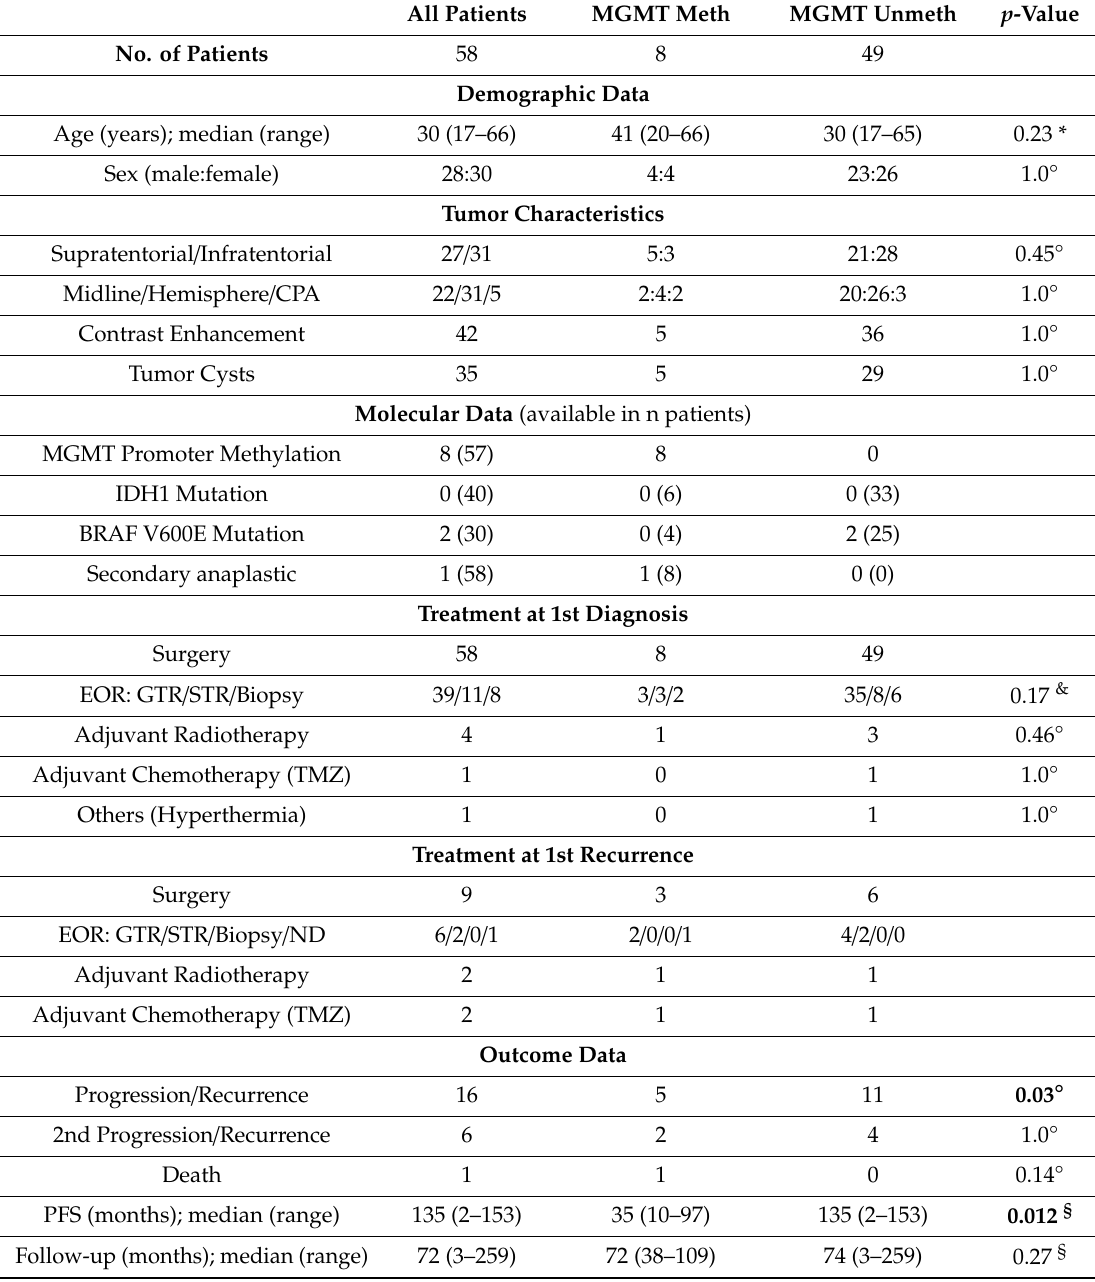
Table 1. Patient characteristics of the complete cohort (n = 58); stratified for MGMT promoter methylation